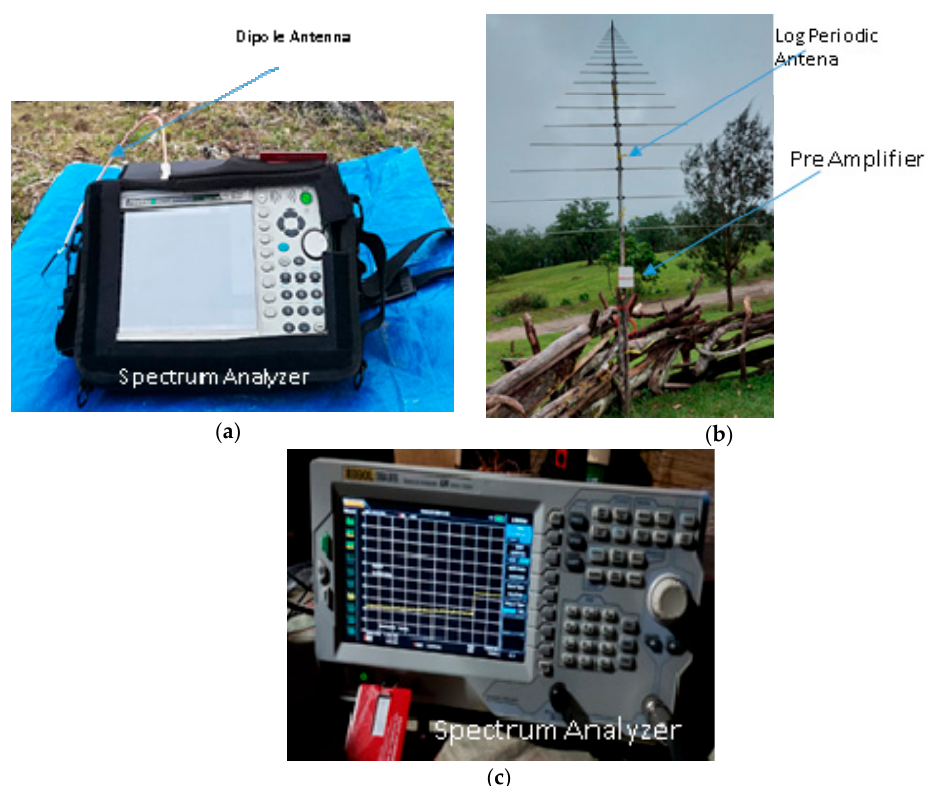
Figure 2. Photos of measurement: ( a ) Anritsu MS2721B; ( b ) log periodic antenna and pre amplifier; ( c ) Rigol DSA 815.